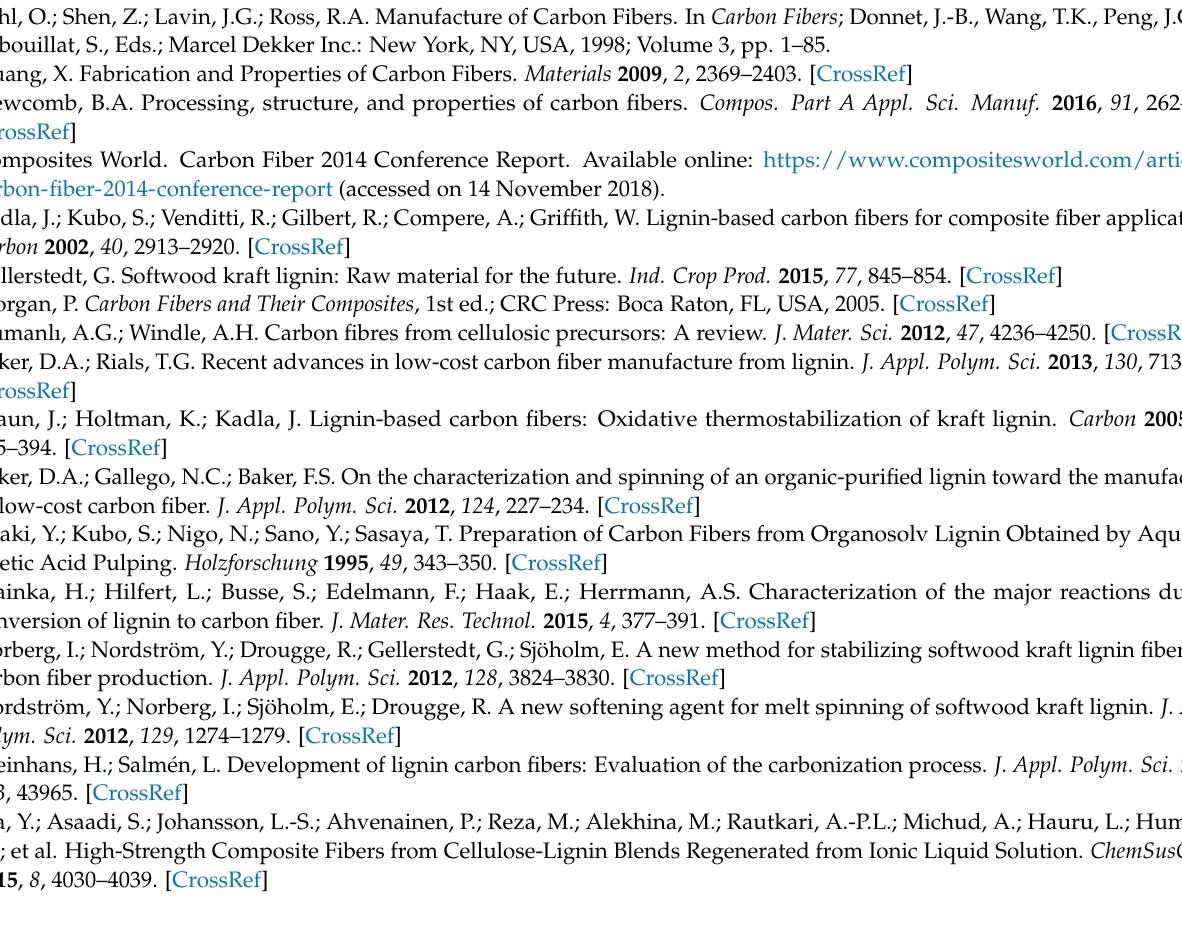
signal assignment, Figure S2: Fitting procedure of Raman spectra, Figure S3: 2D WAXS scattering pattern of precursors, Figure S4: 2D WAXS scattering patterns of CFs, Figure S5: 1D WAXS figures of CFs incl. fitting procedure, Figure S6: Raman spectra of CFs; Table S1: Gravimetric yield